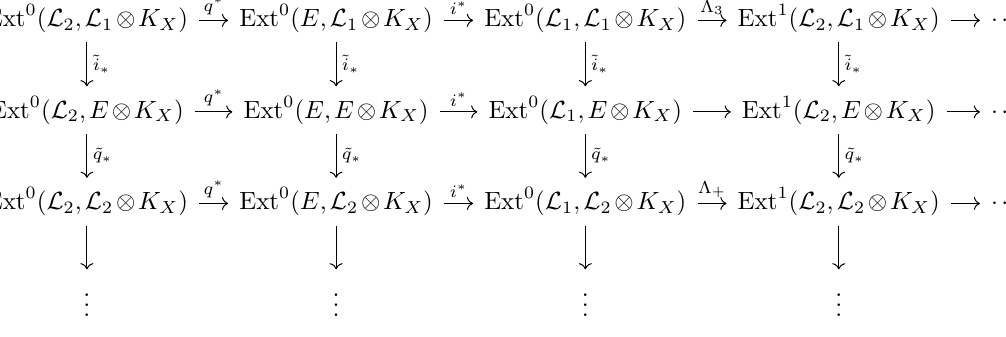
Figure 1 . Grid of long exact sequences in cohomology associated to the sequence